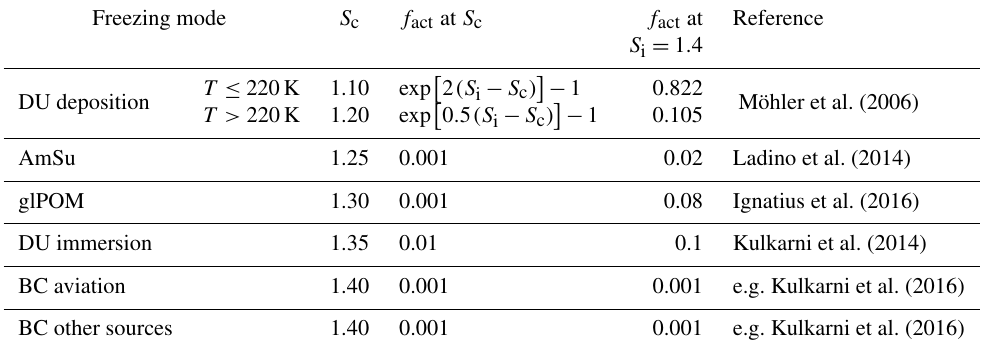
Table 1. Freezing properties of ice-nucleating particles in the cirrus regime assumed in this study, i.e. critical supersaturation ( S c ) and activated fraction ( f act ) at the freezing onset. S i is the supersaturation with respect to ice. In addition to f act values representative of the freezing onset, f act values at about S i = 1 . 4 are used in the